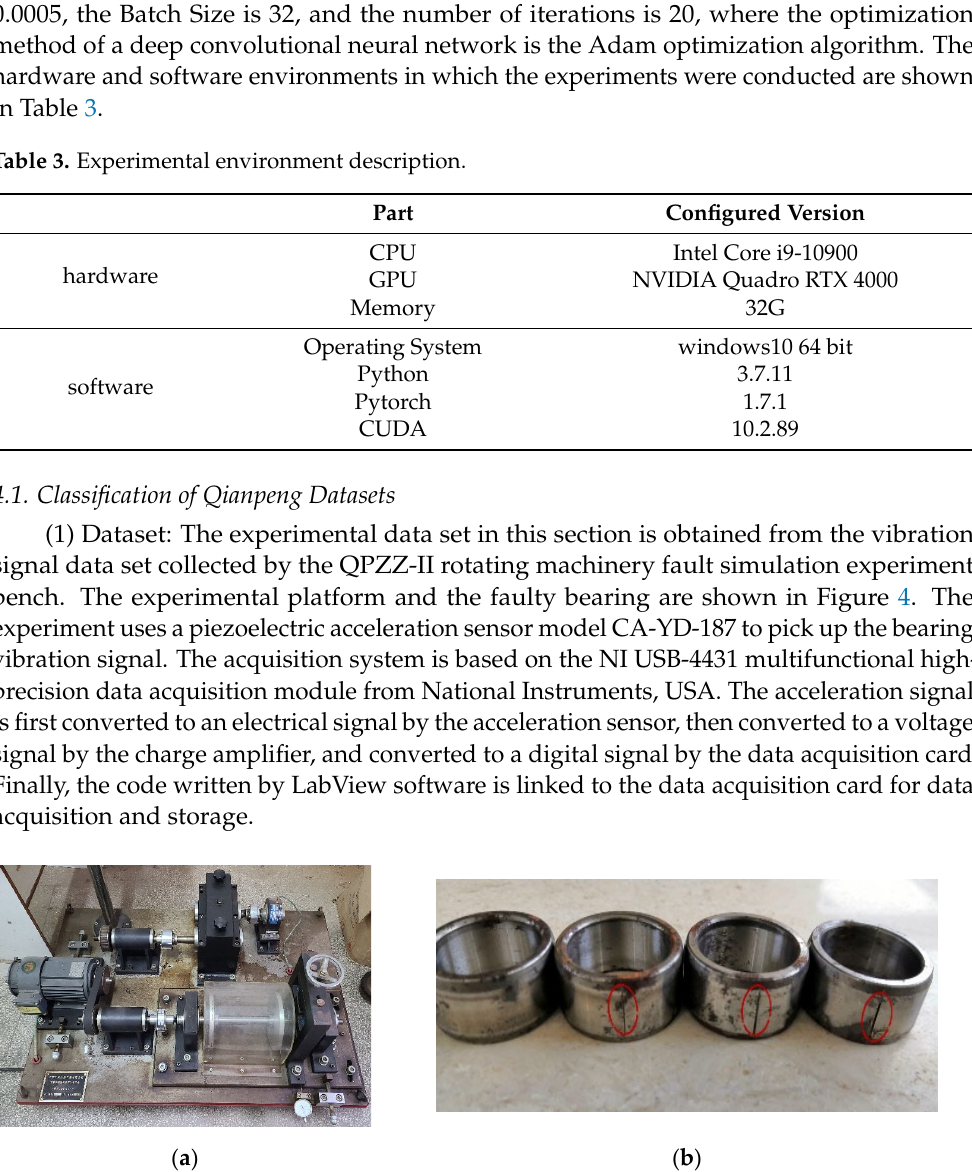
Table 4. Introduction to image data sets.